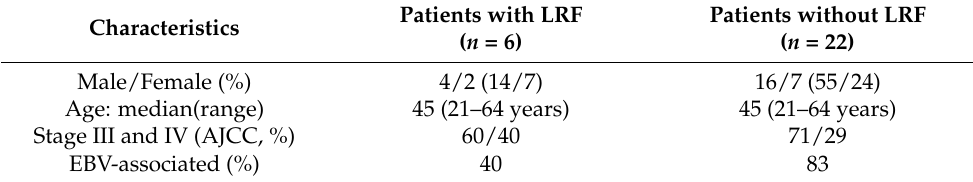
Table 1. Patient characteristics.